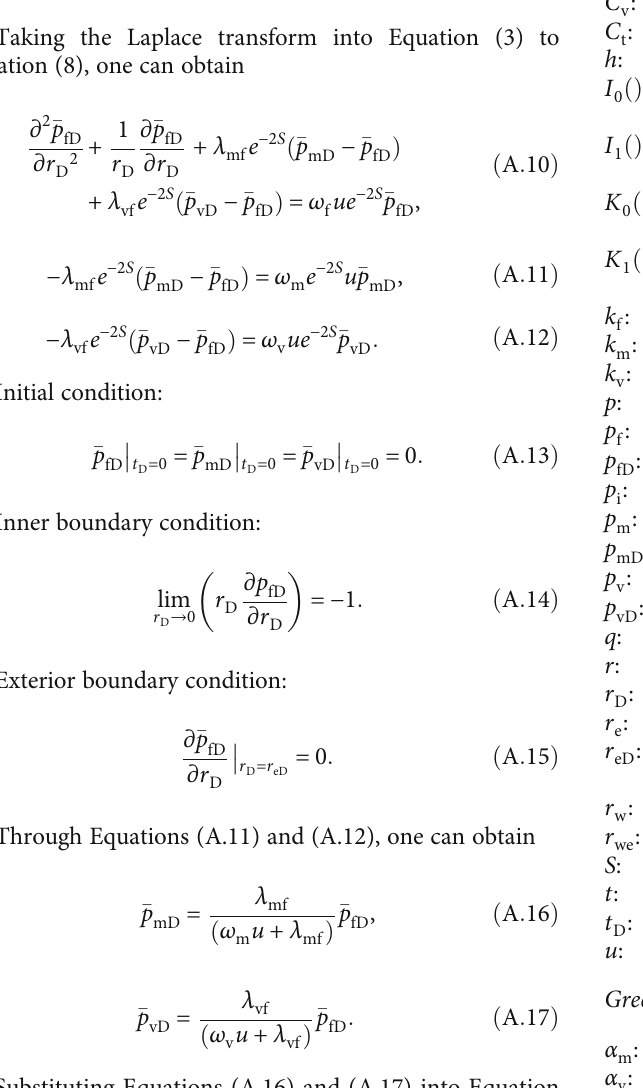
Geometric shape factor of the vug block, m -2 λ system, dimensionless λ fl ow factor of vug system to fracture vf : Interporosity system, dimensionless μ : Fluid viscosity, mPa · s